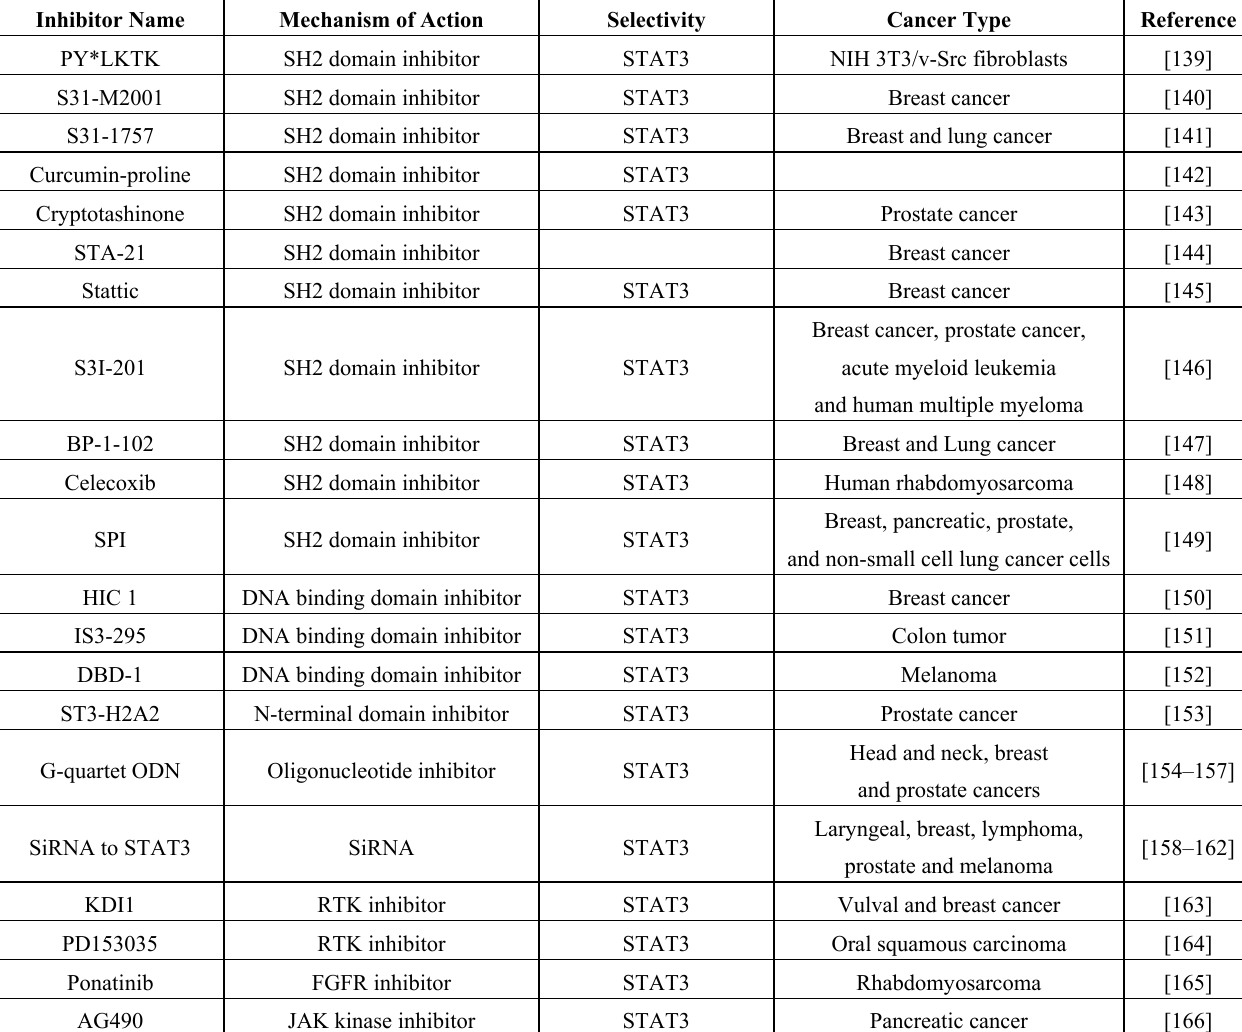
Table 1. Currently Available STAT3